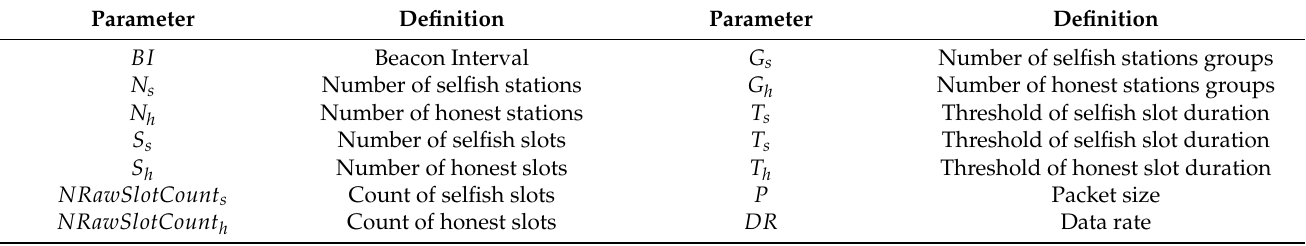
Table 12. SSQPA algorithm parameters.